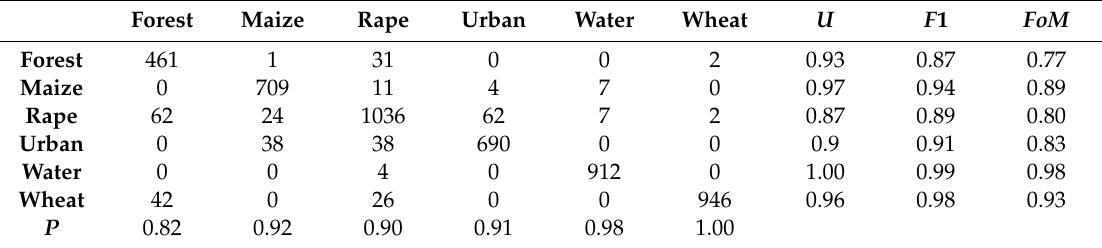
Table 8. Confusion Matrix of the best winter crop classifications obtained using a parameter dataset